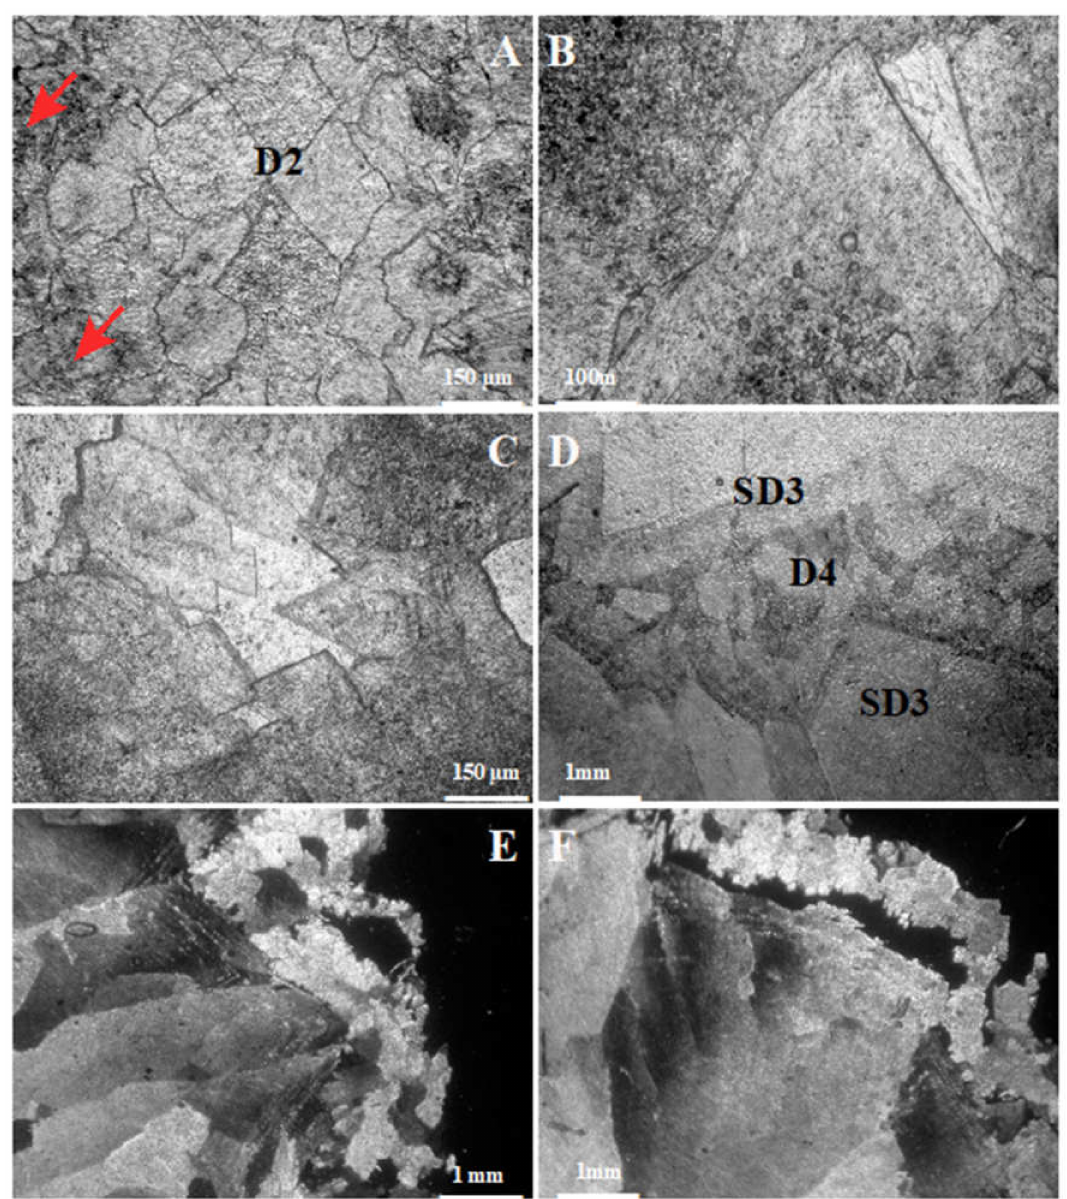
Figure 6. ( A ) Mostly planar-s dolomite D2 J with remaining of a former replacement dolomite D J “lithorelic” (arrows) showing dissolution and irregular compacted grain boundaries. Micrite of precursor facies on the top left corner. ( B ) Saddle dolomite-type SD1 J matrix. The core is rich in inclusions. Thus, this dolomite facies is a key for the replacement of a former dolomite. ( C ) Secondary porosity filled by saddle dolomite SD2 J cement. ( D ) Secondary porosity occluded by late dolomite D4 of di ff erent grain sizes, within SD3 J . ( E , F ) Saddle dolomite SD5 J is characterized by strongly curved crystal boundaries and a sweeping extinction under crossed nicols. D, Dolomite; SD, Saddle